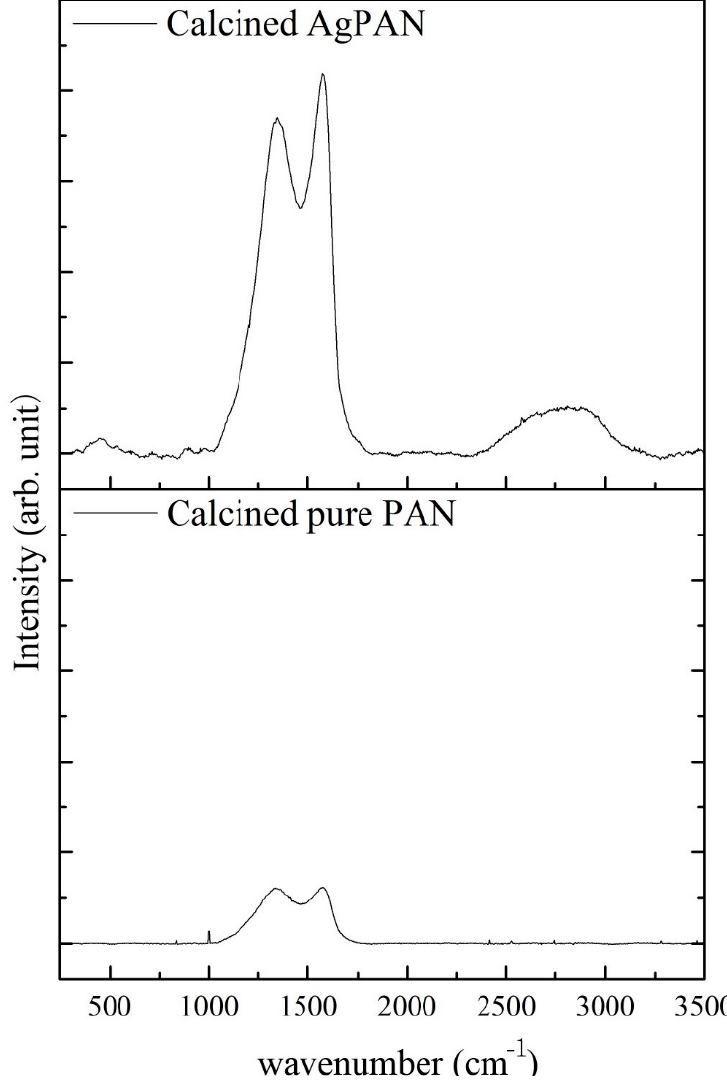
Figure 2. Raman spectrum of calcined pure PAN and Ag/calcined PAN.